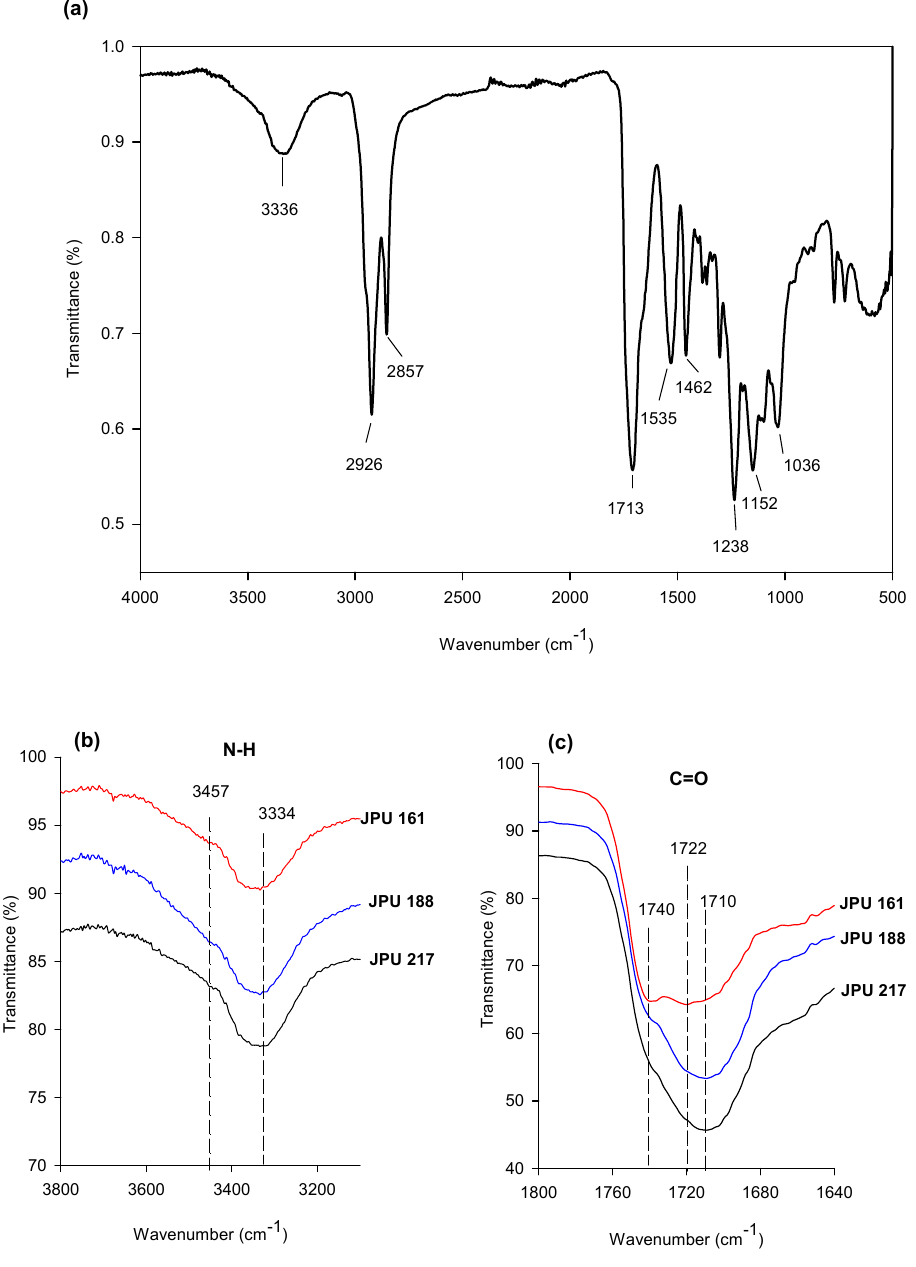
Figure 5. FTIR spectra of ( a ) JPU 217 film, ( b ) amide region of JPU films, and ( c ) carbonyl regions of JPU films.